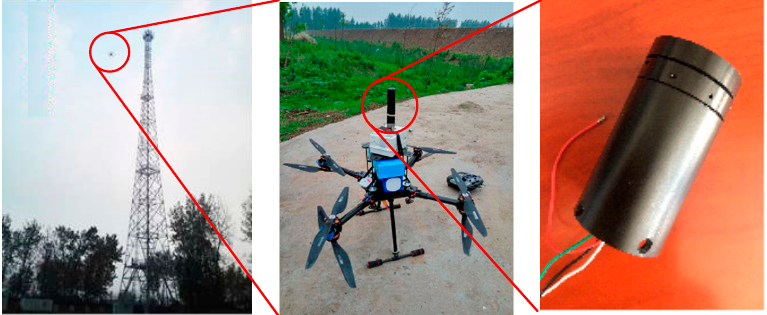
Figure 7. The quadcopter meteorological application.